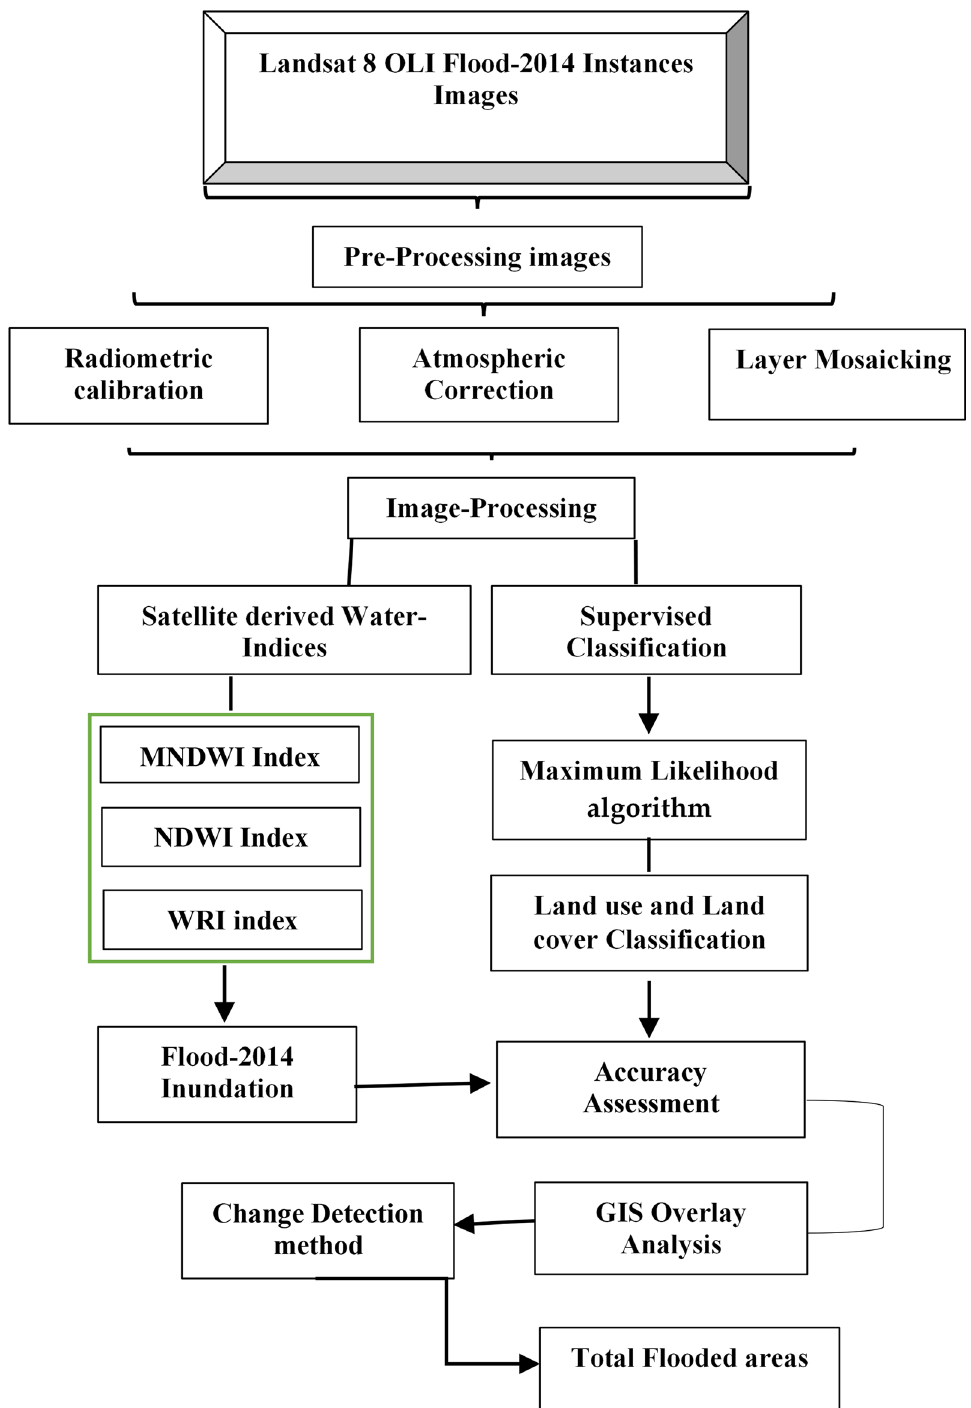
Fig. 2 Methodological outline for RFM using Landsat-8 flood